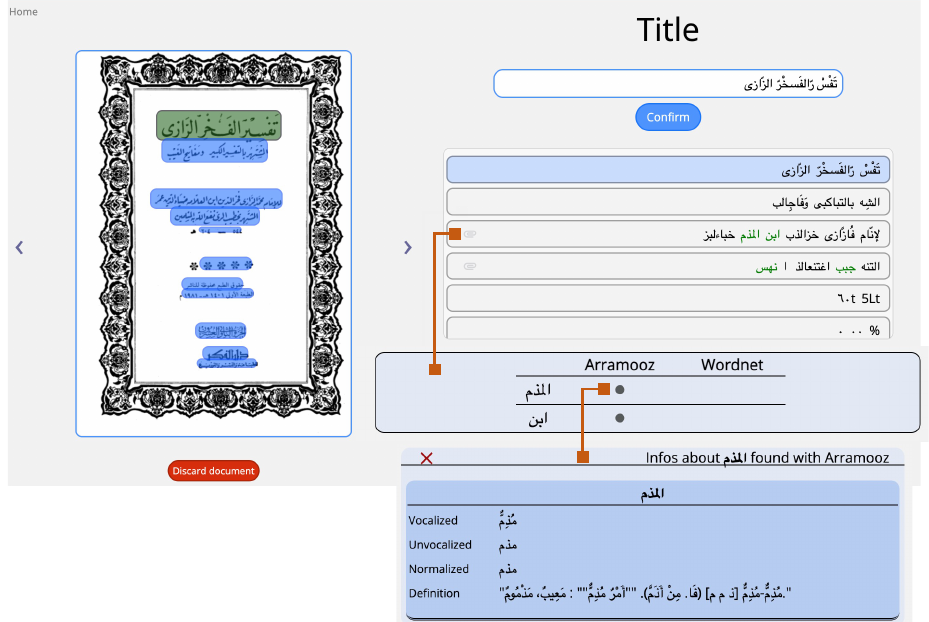
Figure 6. Preliminary resulting cataloguing tool prototype UI: document cataloguing (title window), showing the actual extraction of the title (highlighted in the green box, on the frontispiece displayed on the left). From top to bottom on the left side, the title is hinted before confirming and also selected in blue under the confirm button. Arramoz and Wordnet are the employed linguistic resources, in this case activated (in green) on the word ibn “son” and al-mudhimm “the one who reprehends, the